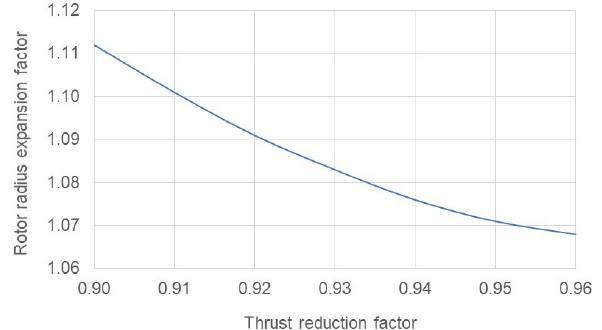
Figure 4. Axial induction distributions giving rise to the same out- of-plane bending moment, M 0 , at rotor centre.